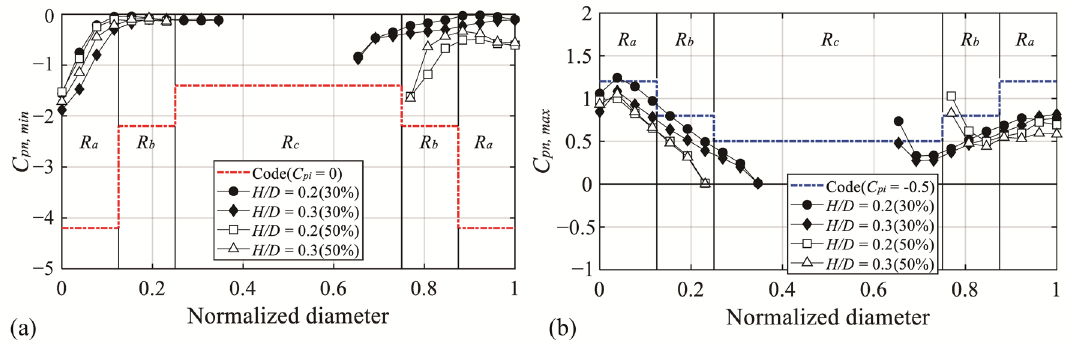
Figure 20. Comparison of the peak net pressure coefficients of AIJ-RLB (2015): ( a ) C pn,min and ( b ) C pn,max .